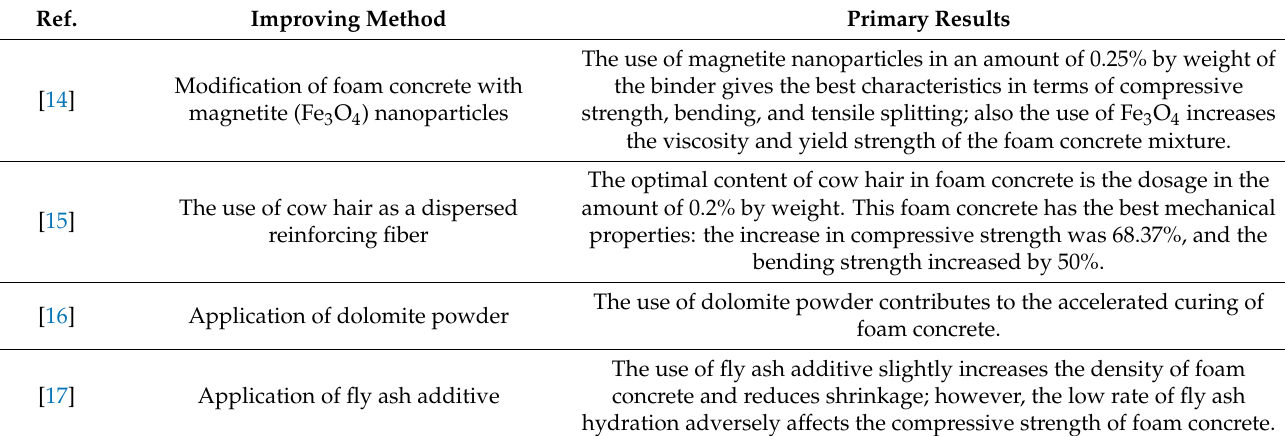
Table 2. Overview of various methods for modifying and improving the physical and mechanical characteristics of foam concrete and foamed